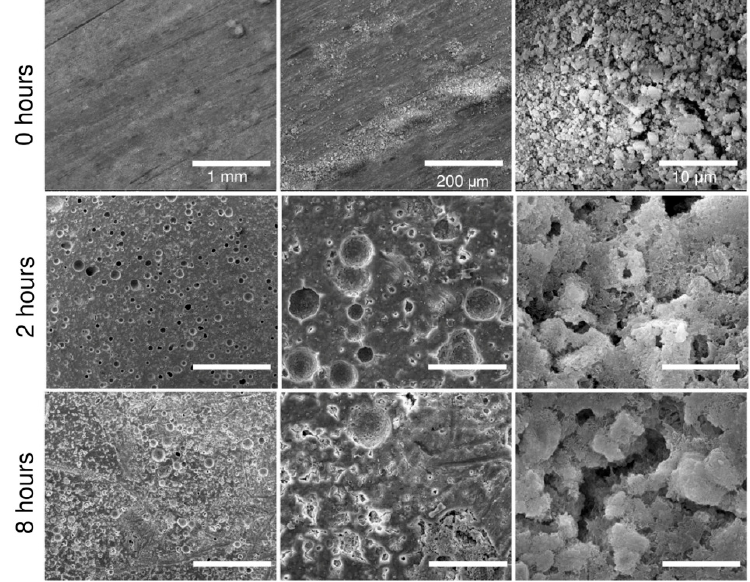
Figure 8. SEM images of the microstructure of the CPCs with the 20 w / v % copolymer and an L/P ratio of 0.5 g · g − 1 (set for 10 days at 37 ◦ C) after 0, 2 and 8 h of accelerated degradation with a scale bar of 1 mm (left), 200 µ m (centre) and 10 µ m (right).